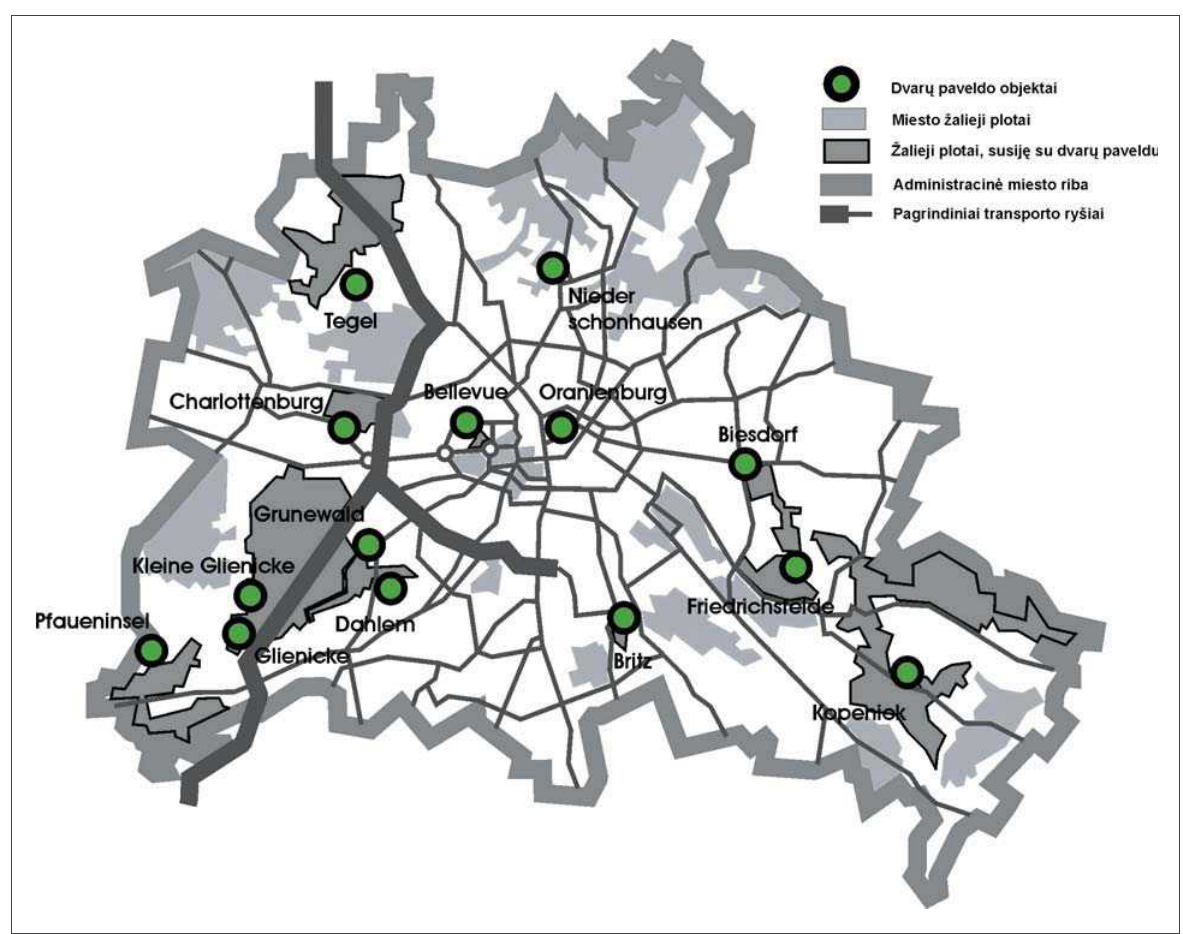
Fig 3. Use of former manor greenery for quantitative urban development. Berlin